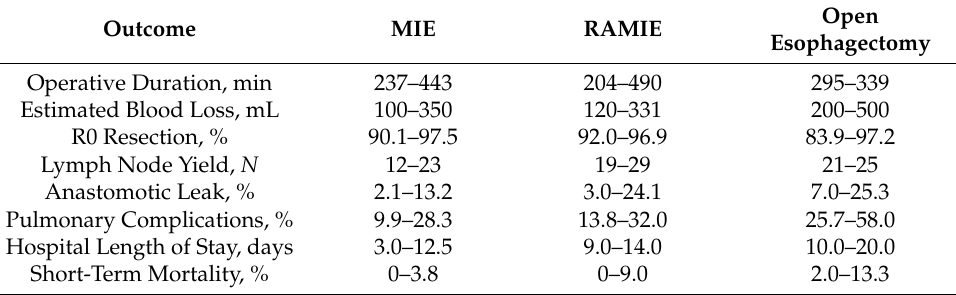
Table 2. Ranges of reported perioperative outcomes by surgical